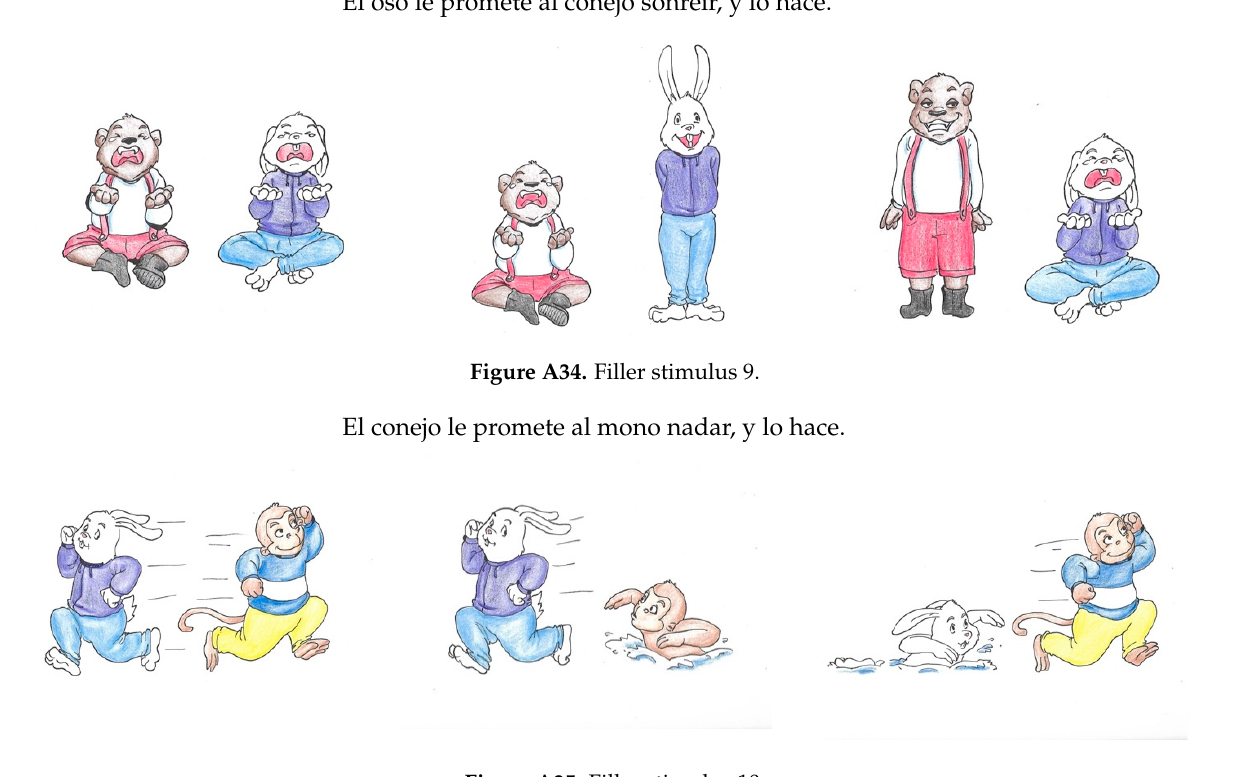
Figure A35. Filler stimulus 10.